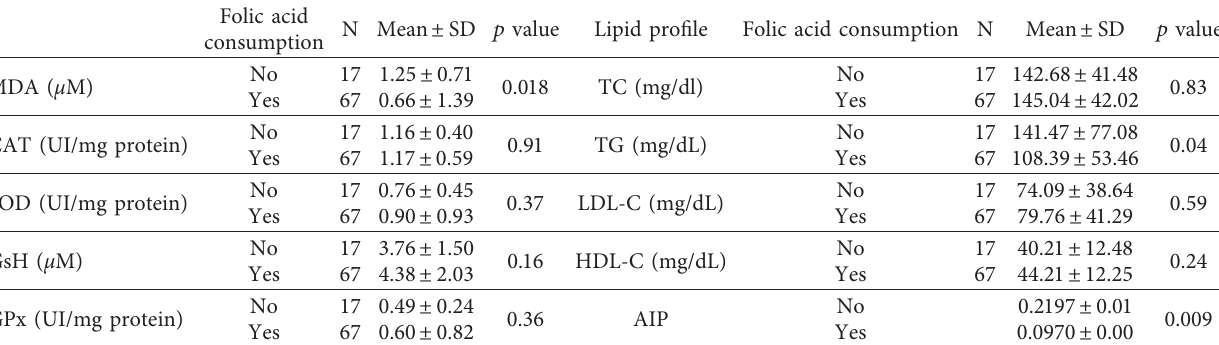
Table 6: Influence of folic acid intake on some markers of oxidative stress and lipid